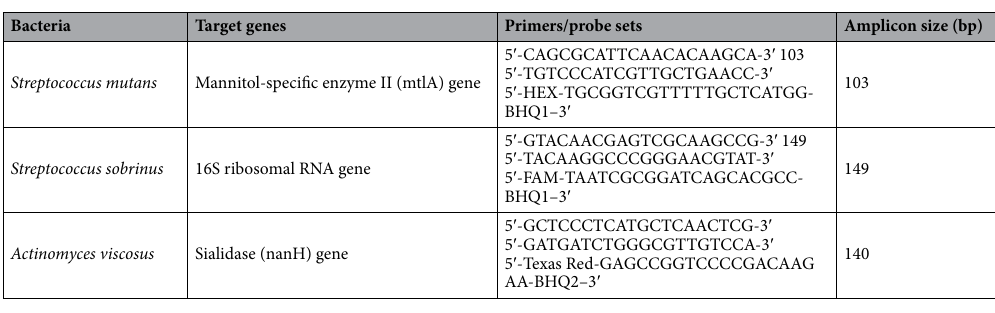
Table 1. Primers and probes used in the real-time PCR